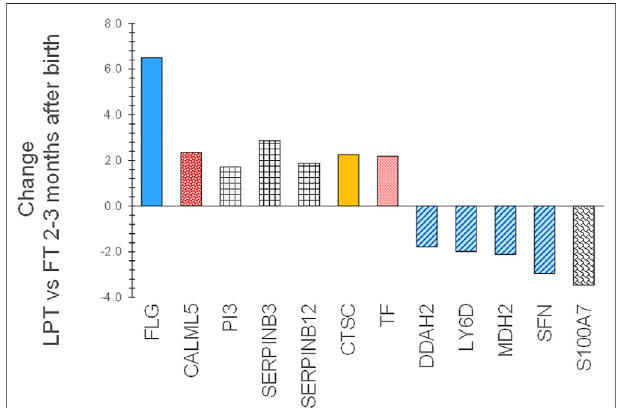
FIGURE 6 | Changes in SC proteins for LPT infants compared to FT infants 2 – 3 months after birth at comparable corrected GA. Two sequential skin surface samples (stratum corneum) were collected from the lower legs of 61 infants at each time and from the volar forearms of 34 adults (parent) at one time. Samples were extracted, quanti fi ed with liquid chromatography tandem mass spectrometry, and analyzed using targeted proteomics ( p < 0.05) (Visscher et al., 2020; Visscher et al., 2021). LPT infants had increased expression of protease inhibitors PI3, SERPINB3, and SERPINB12, aswell as FLG, CALML5, CTSC, and TF versus FT infants. Expression of S100A7, LY6D, SFN, MDH2, and DDAH2 was lower in LPT compared to FT 2 – 3 months later. These fi ndings suggest that the rate of change of speci fi c aspects of epidermal barrier development may vary with GA and/or time from